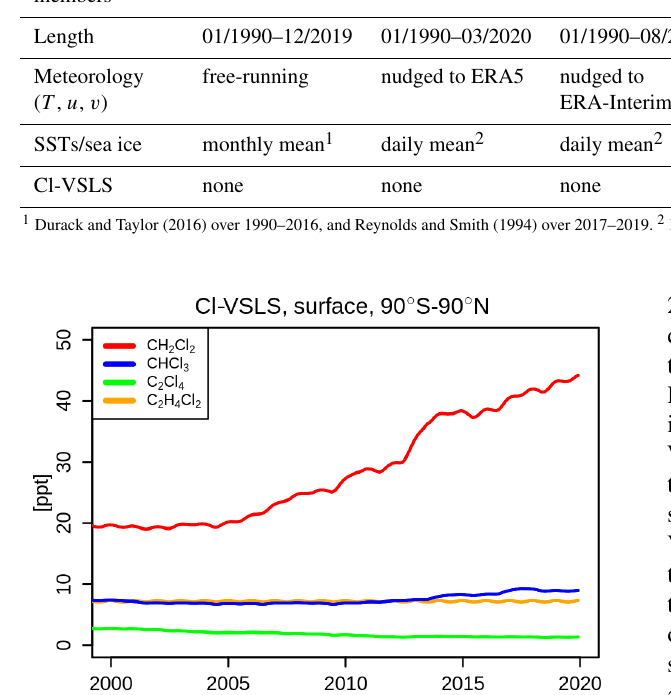
Figure 1. Global mean volume mixing ratios [ppt] of CH 2 Cl 2 (red), CHCl 3 (blue), C 2 Cl 4 (green) and C 2 H 4 Cl 2 (orange) simulated at the surface in the VSLS